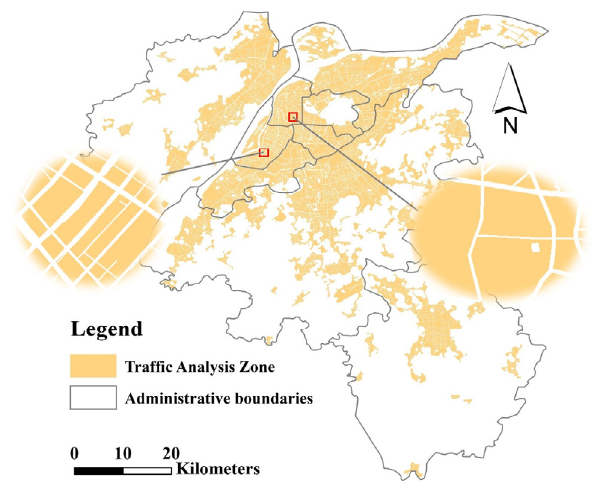
Figure 2. Distribution of TAZs in the study area.